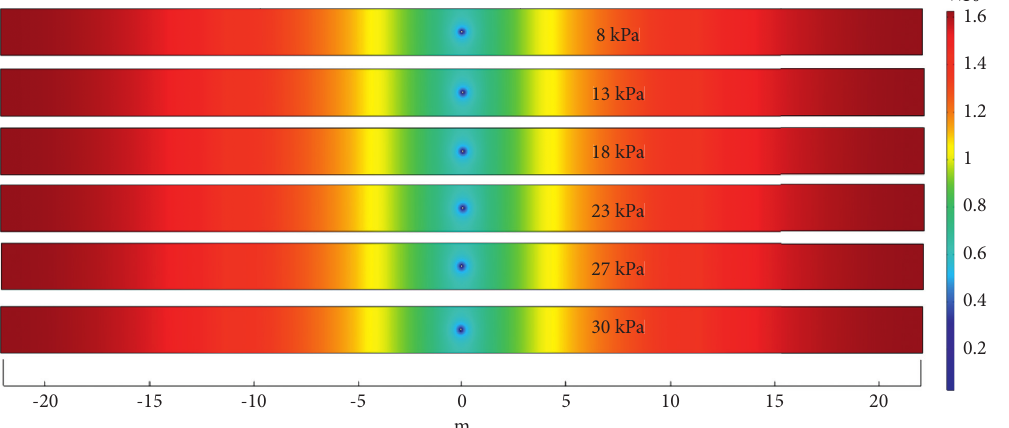
Figure 2: Cloud diagram of the influence range of different extraction negative pressure changes.